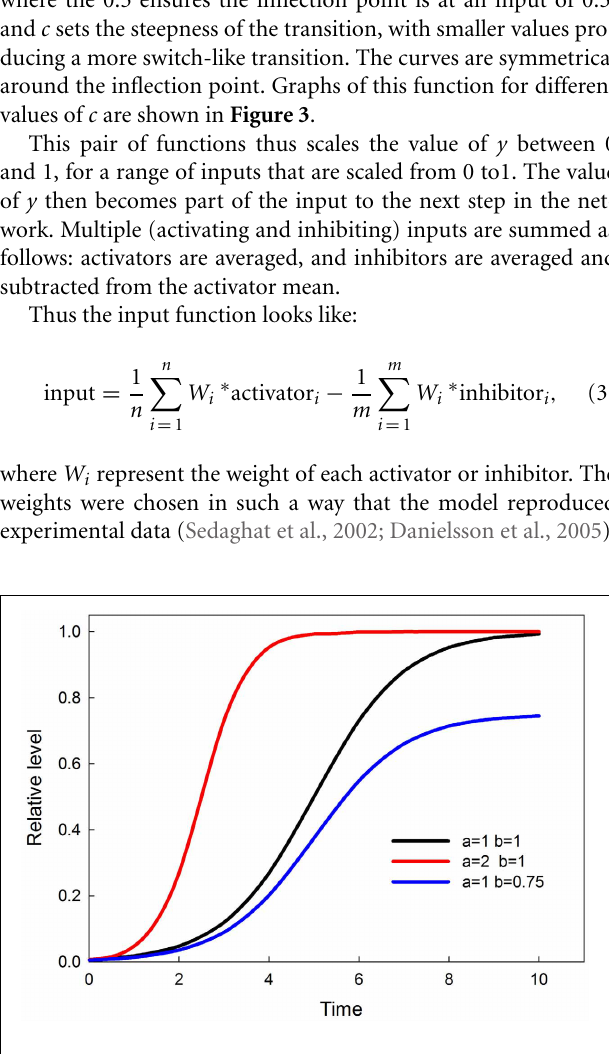
FIGURE 2 | Time-dependent sigmoids (effect of parameters a and b ). Parameter a controls when the response attains saturation. Parameter b controls the saturation point of the